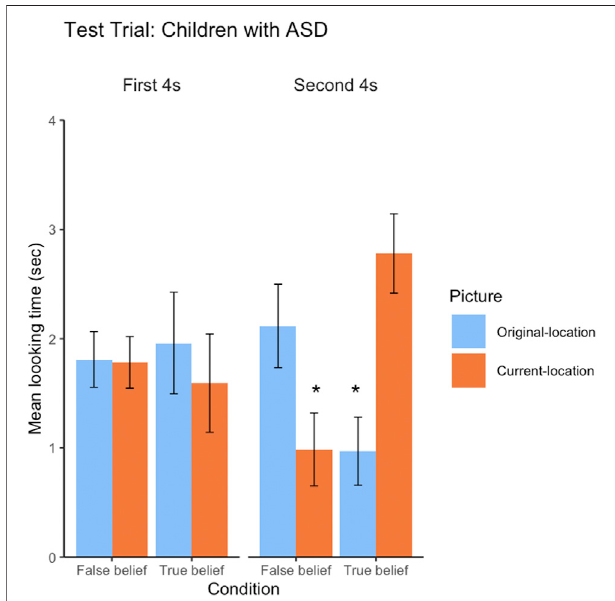
FIGURE 3 | Children in the ASD group ’ s mean looking time (in seconds) to the original-location and current-location pictures in thetest trial,separately by condition and window. Error bars represent standard errors and asterisks indicateasigni fi cantinlooking timetothetwopictures withinacondition ( p <